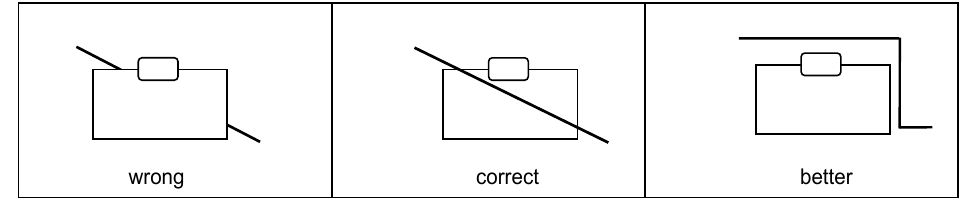
Figure 4.2: If an edge crosses a node, the edge must be drawn on top of the